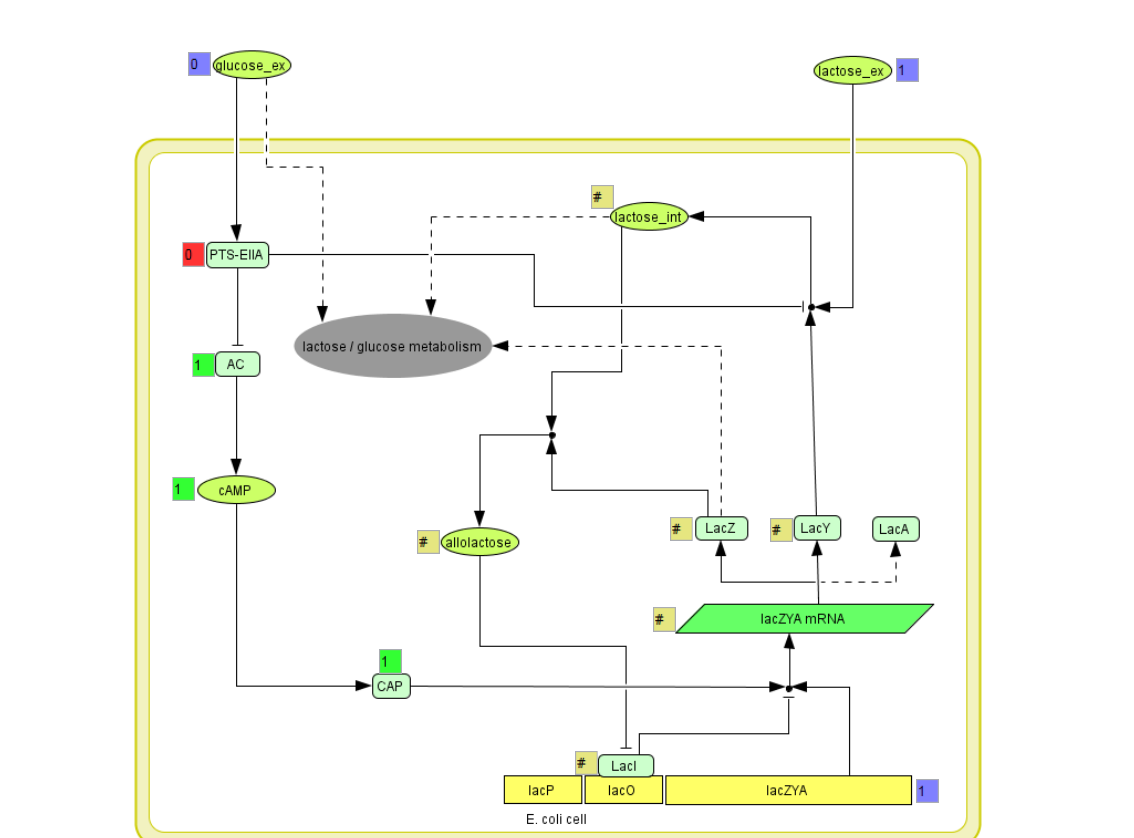
Figure 2: Logical steady state in the binary lac operon model for the -glucose/+lactose scenario (screenshot from CellNetAnalyzer ). Colour-code for the boxes: blue=predefined state; green=calculated “on” state; red=calculated “off” state; brown=undefined